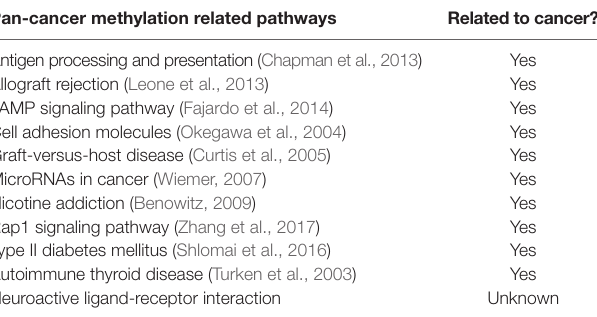
TABLE 2 | PMPs and their corresponding relations to cancer. Pan-cancer methylation related pathways Related to cancer? Antigen processing and presentation (Chapman et al., 2013)